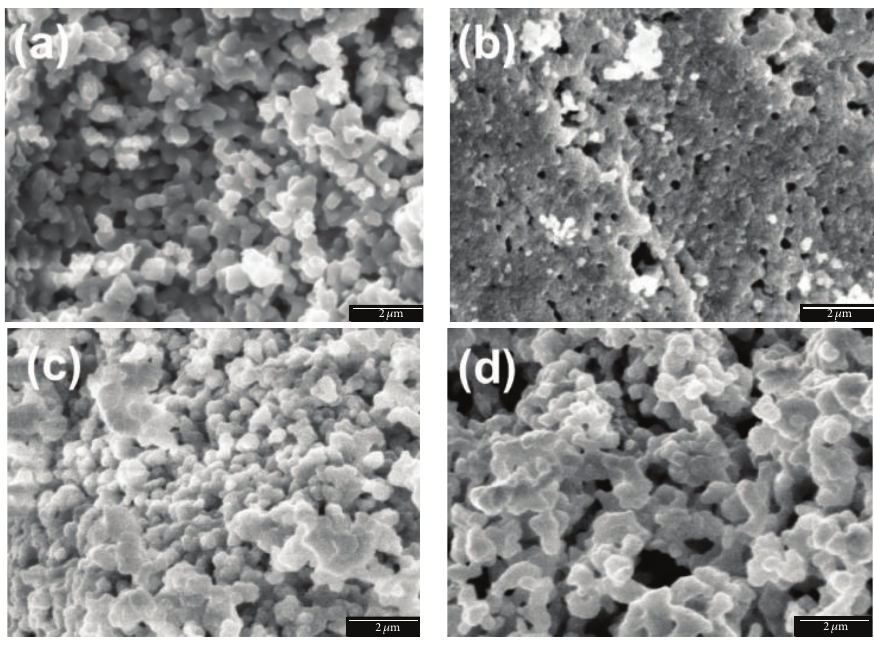
Figure 3: SEM images of (a) STO, (b) STO iso , (c) STO3, and (d) STO7